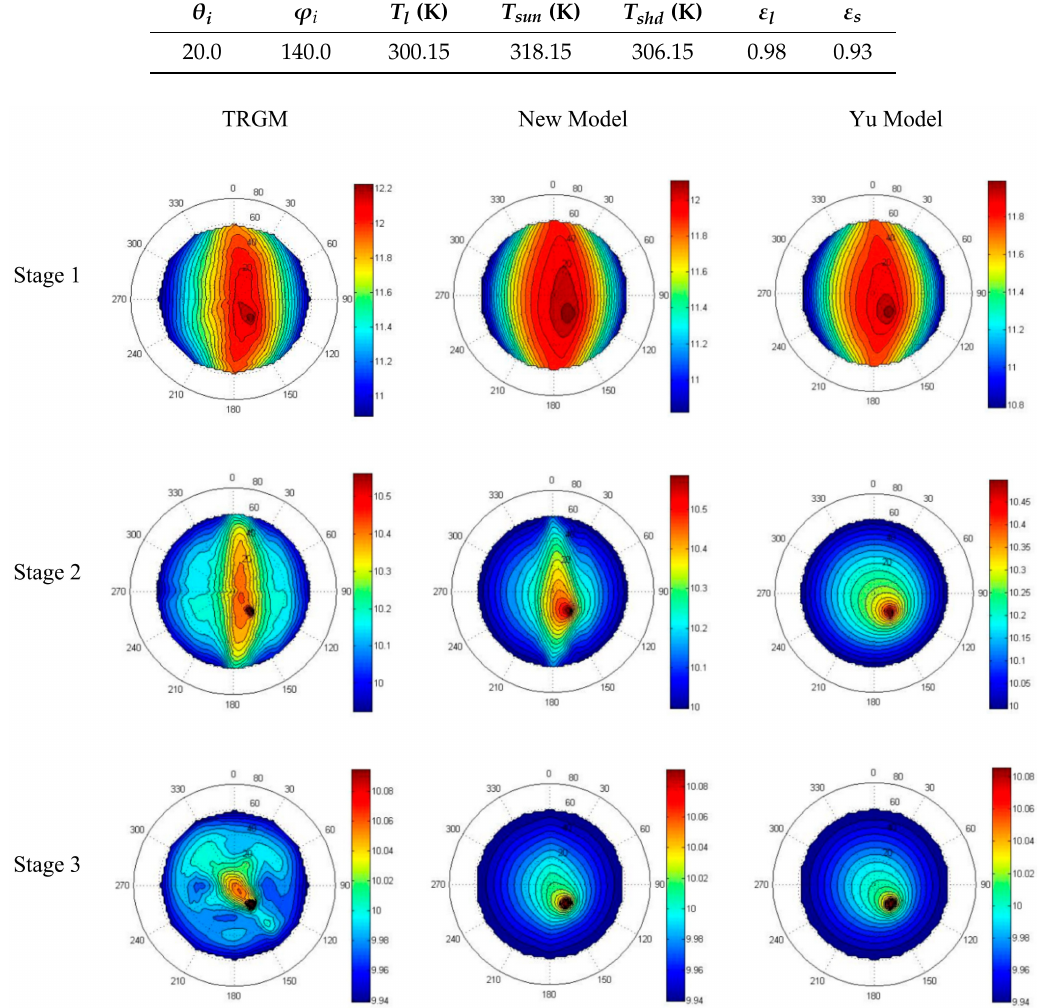
Figure 4. Polar plots of simulated directional radiance (DR), units: w / m 2 / sr / µ m . TRGM, thermal radiosity-graphics combined